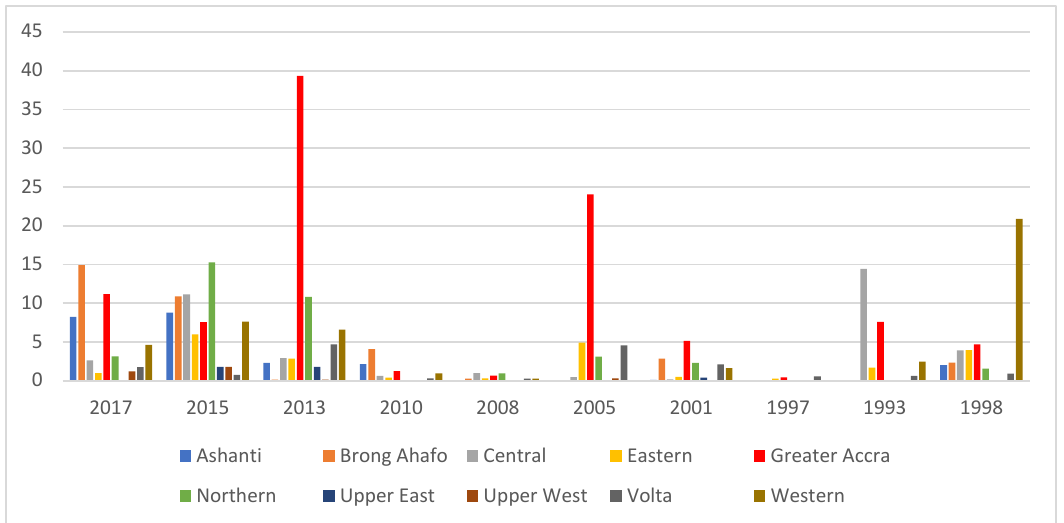
Figure 4. Regional distribution of urban agricultural land loss due to urbanization. Source: Agricultural Stress Index, FAO (2017).